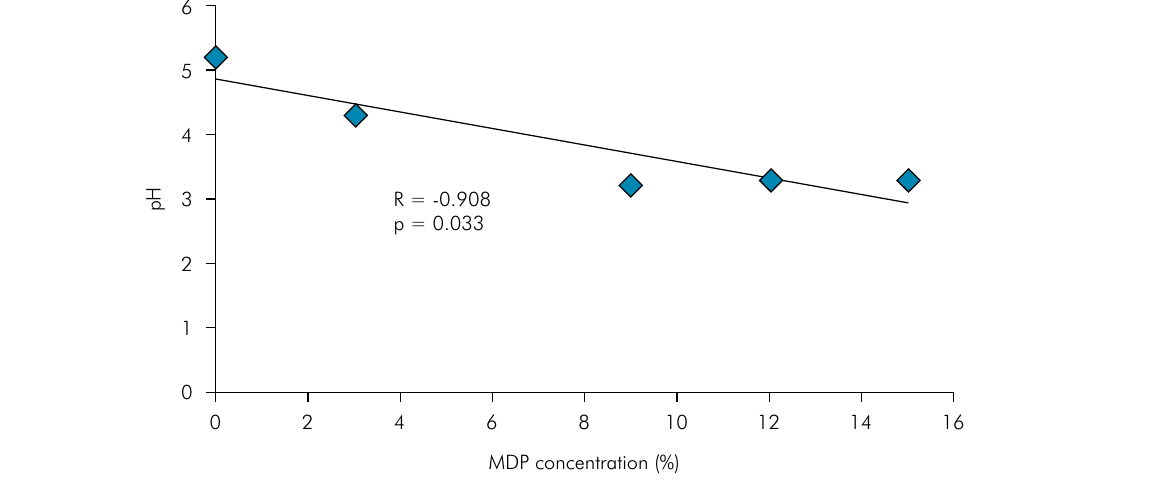
Figure 3. Correlation between pH and MDP concentration for the experimental